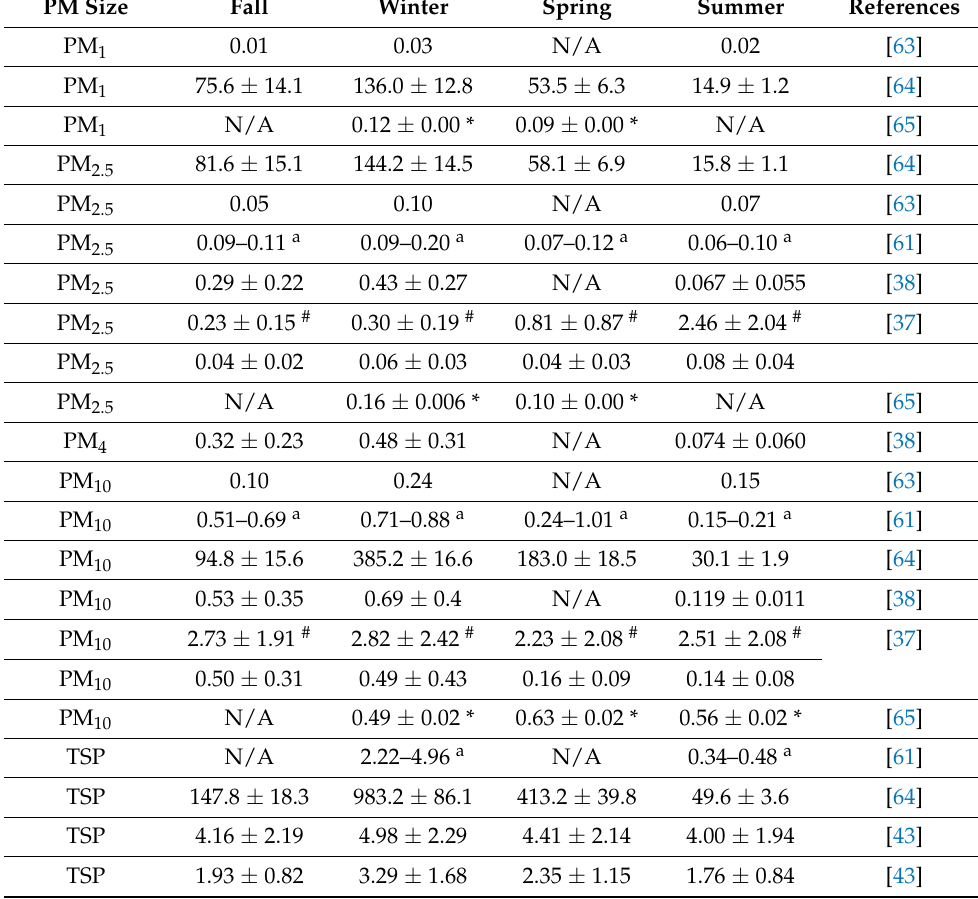
Table 4. Particulate matter concentration (mg/m 3 ) as affected by seasons.